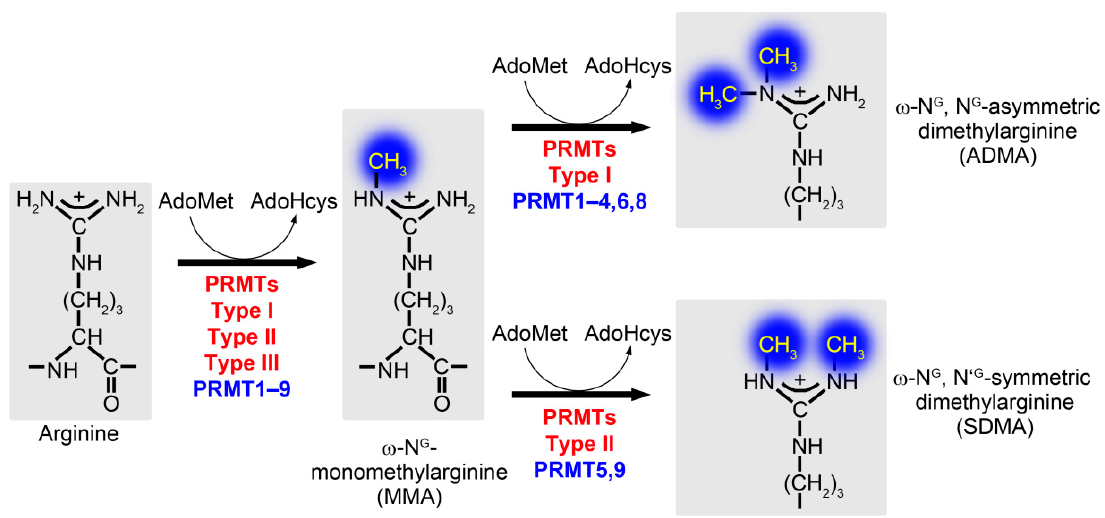
Figure 1. Protein Arginine Methylation by PRMTs. All three types of PRMTs (types I–III) are able to methylate one of the equivalent, terminal ( ω ) nitrogen atoms ( ω -N G and ω -N’ G ) using S-adenosylmethionine (SAM; AdoMet) as a methyl donor. The reaction leads to the generation of S-adenosylhomocystein (AdoHcys) and monomethylarginine (MMA). Type III PRMTs (PRMT7) exclusively catalyze this initial step. Type I PRMTs (PRMT1–4, 6 and 8) can in addition methylate the already monomethylated guanidine nitrogen atom of MMA further, leading to an asymmetric dimethylarginine (ADMA). In contrast, type II PRMTs (PRMT5 and PRMT9) methylate the second, thus far not methylated, terminal guanidine nitrogen atom of MMA ( ω -N’ G ) and thereby give rise to a symmetric dimethylarginine (SDMA).